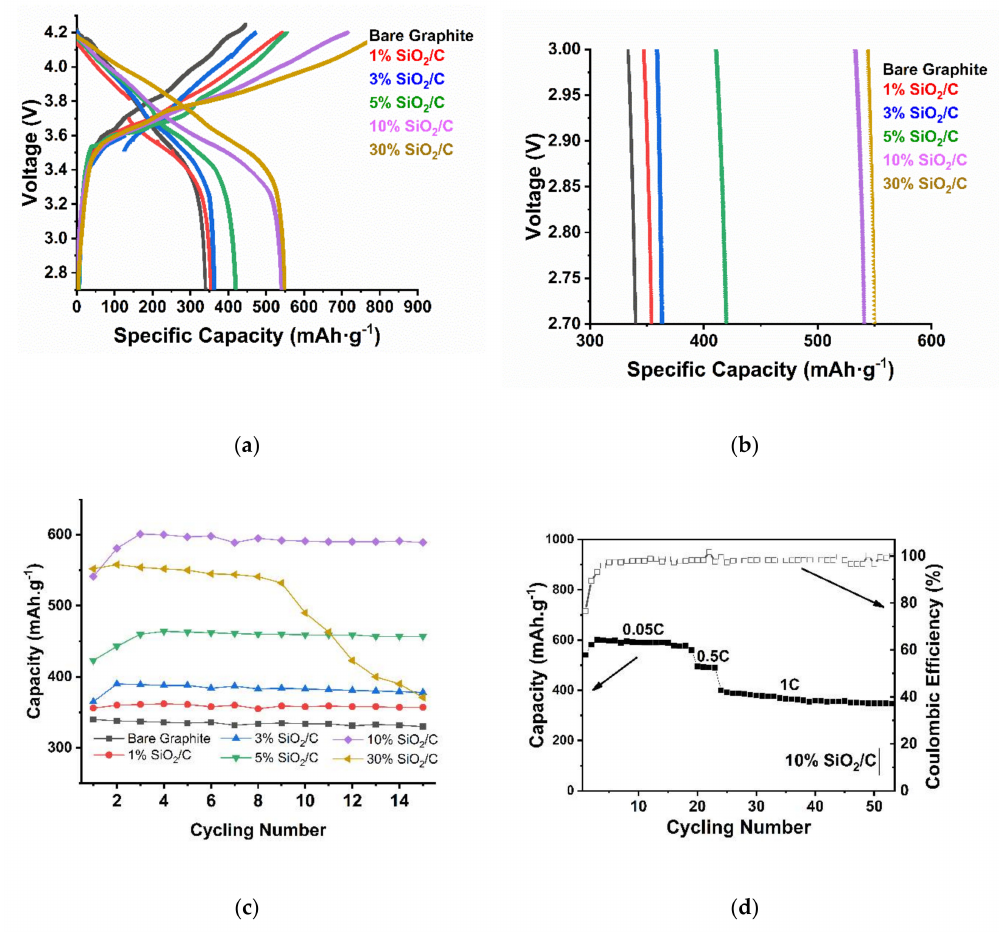
Figure5. ( a )Initialcharge / dischargecurveofthesamplesatdi ff erentSiO 2 contentat0.05C;( b )magnified charge–discharge curve of the samples; ( c ) cycling performance of the samples at di ff erent SiO 2 content; ( d ) rate and cycling performance of the SiO 2 / C 10%